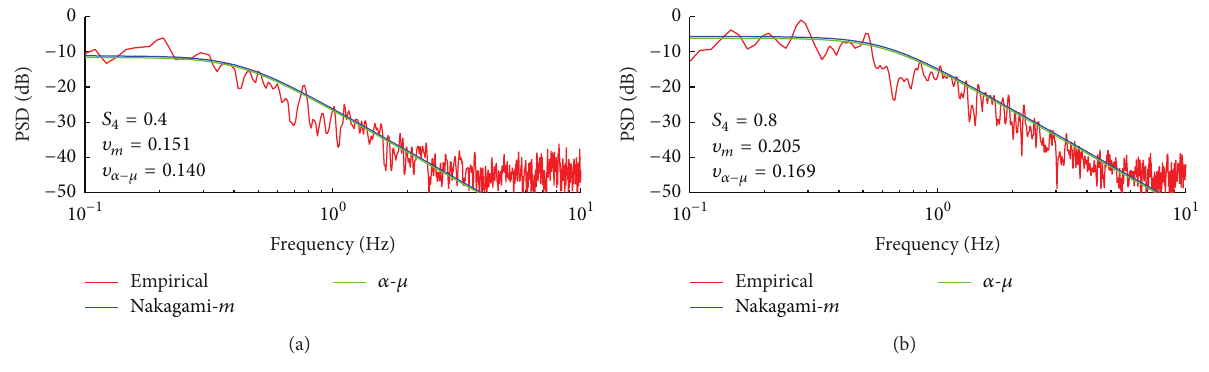
Figure 6: Comparison between estimated scintillation power spectral densities (red) and corresponding results from the theoretical 𝛼 - 𝜇 (green) and Nakagami- 𝑚 (blue) formulations for different values of the scintillation index 𝑆 4